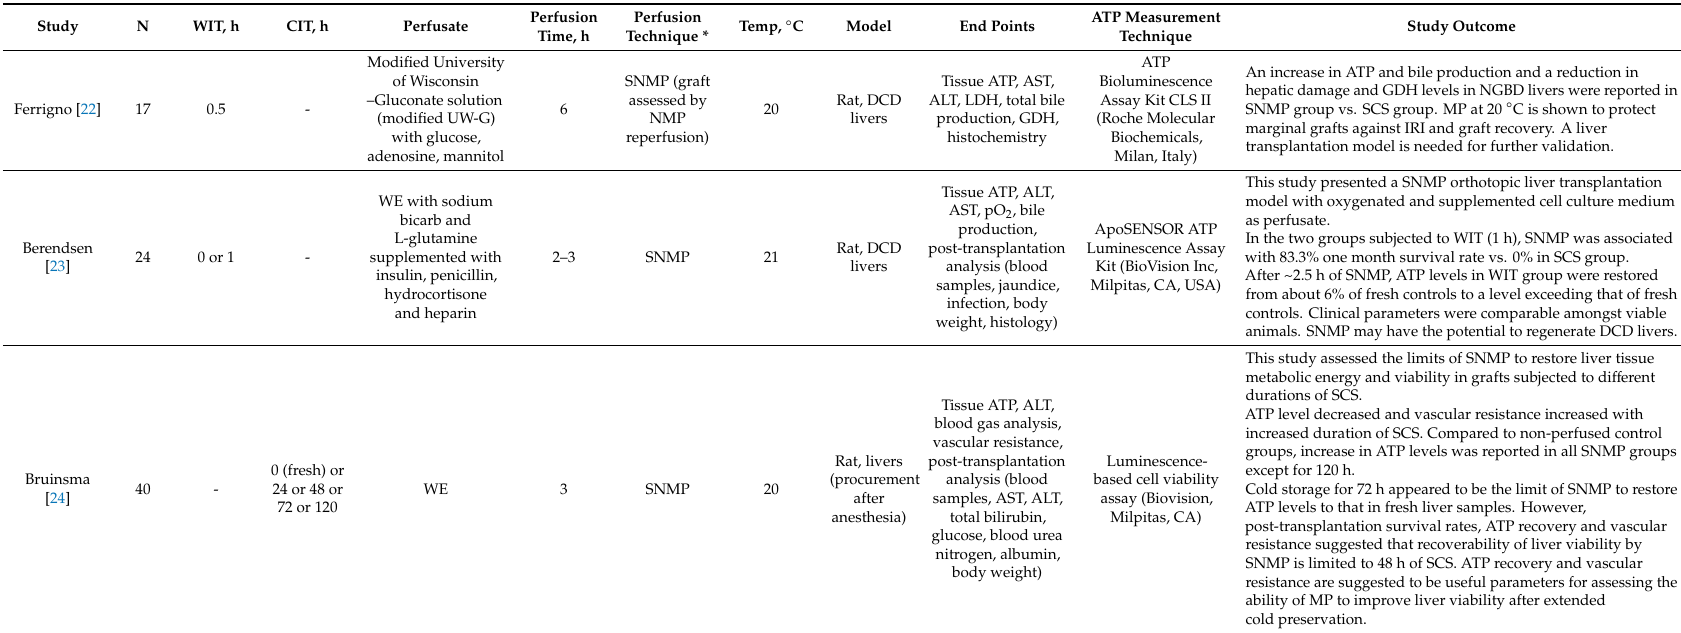
Table 2. Characteristics and outcomes of key pre-clinical and animal studies investigating SNMP preservation of